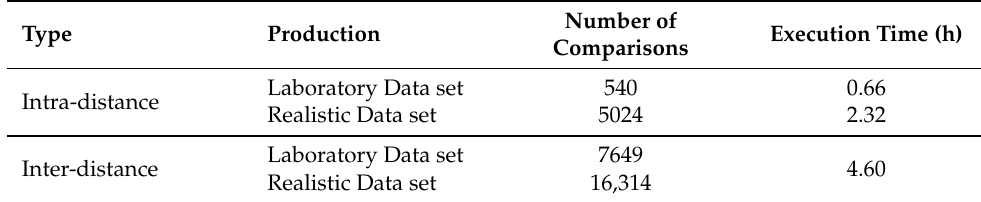
Table 4. Dataset for Process One and Process Two.